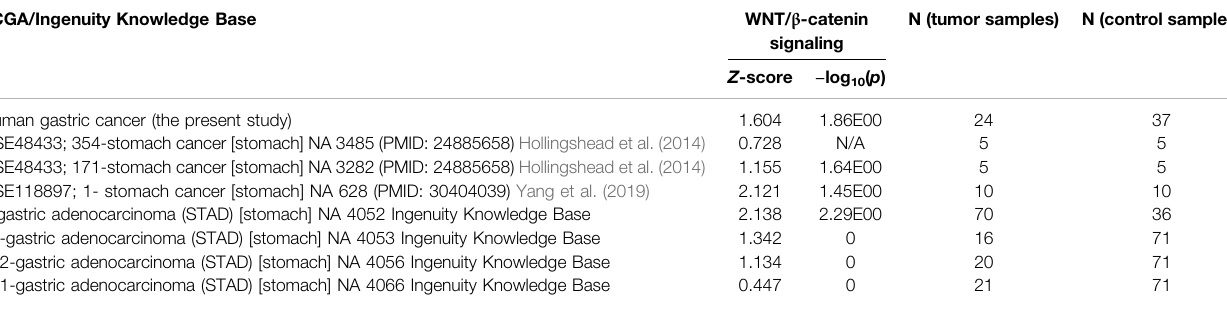
TABLE 2 | WNT/ β -catenin signaling in human gastric cancer (one in the present study and 7 STAD datasets deposited in the TCGA database). TCGA/Ingenuity Knowledge